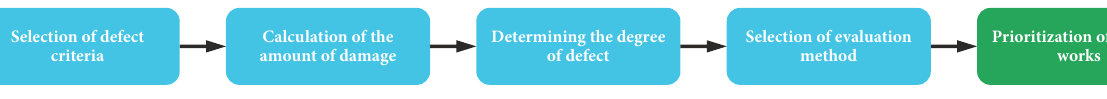
Figure 4. Developed algorithm for the assessment of